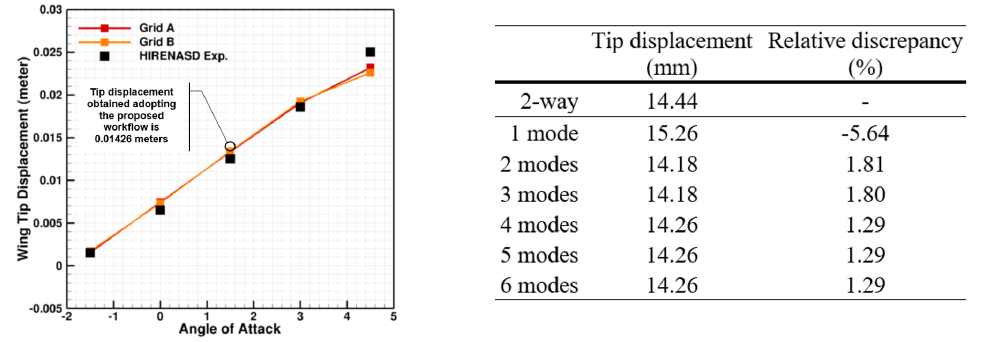
Figure 12. ( Left ): displacements compared to experimental results. ( Right ): comparison to 2-way method